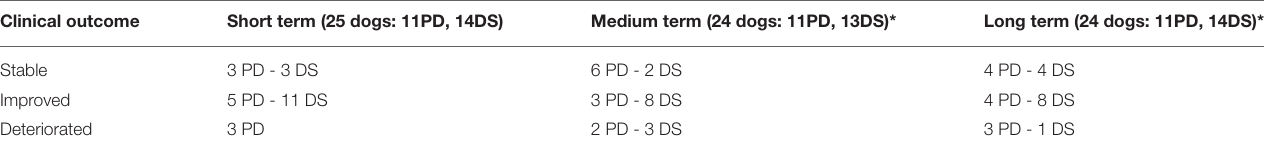
TABLE 2 | Number of dogs and their post-operative outcome (stable, improved, and deteriorated) at different follow-up times (short-term: within 30 days; medium-term: over 30 days and within 1 year; long-term: over 1 year), for both surgical technique (PD, prosthetic disc; DS, Distraction-Stabilization). Clinical outcome